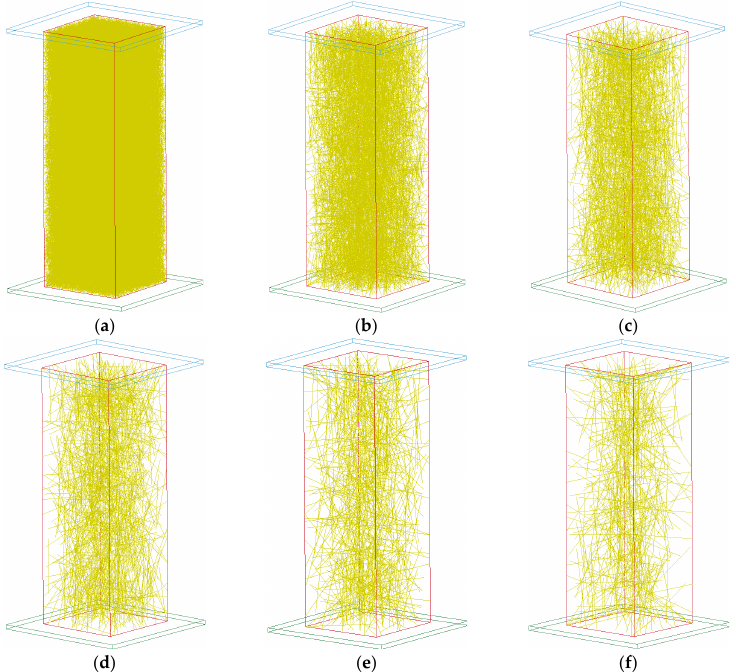
Figure 10. Distribution of steel fibers in matrix with different n : ( a ) n = 1, 146,913 beam elements; ( b ) n = 3, 5442 beam elements; ( c ) n = 4, 2296 beam elements; ( d ) n = 5, 1176 beam elements; ( e ) n = 6, 681 beam elements; ( f ) n = 7, 429 beam elements. Table 2. Critical CBIS algorithm parameters under different n .